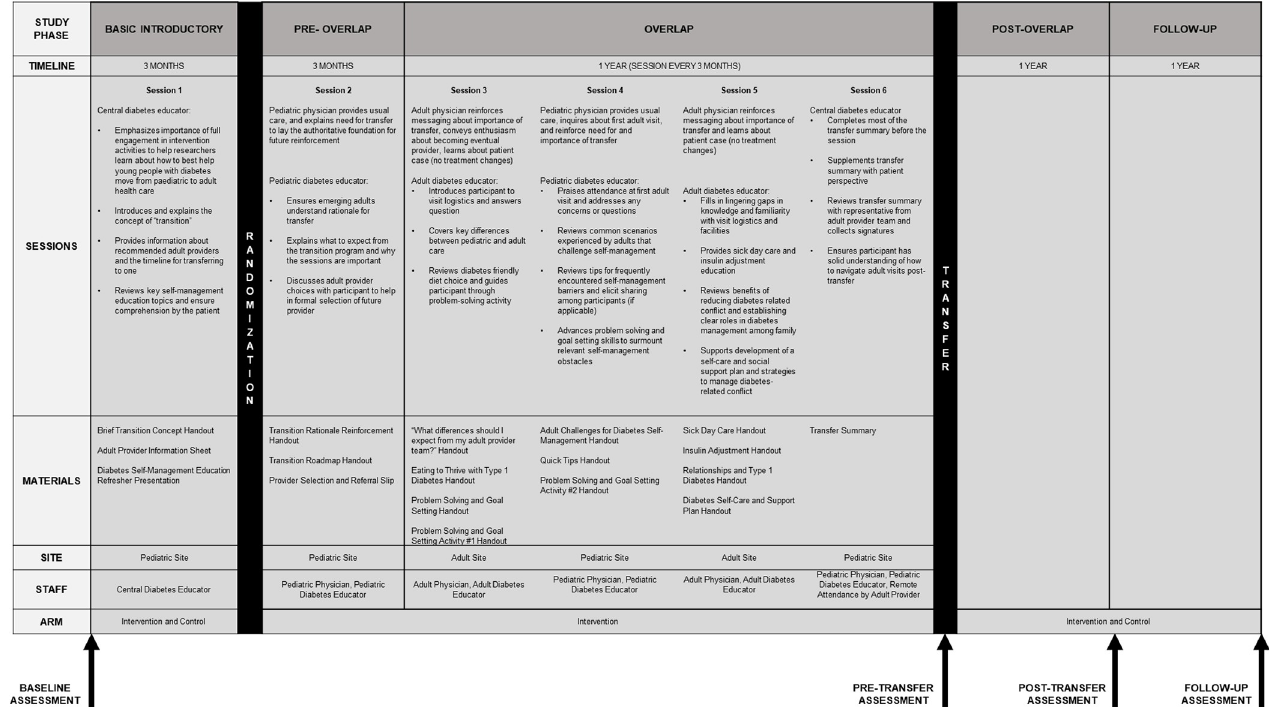
Fig 2. Detailed description of PATHWAY intervention program timeline, sessions, materials, sites, and